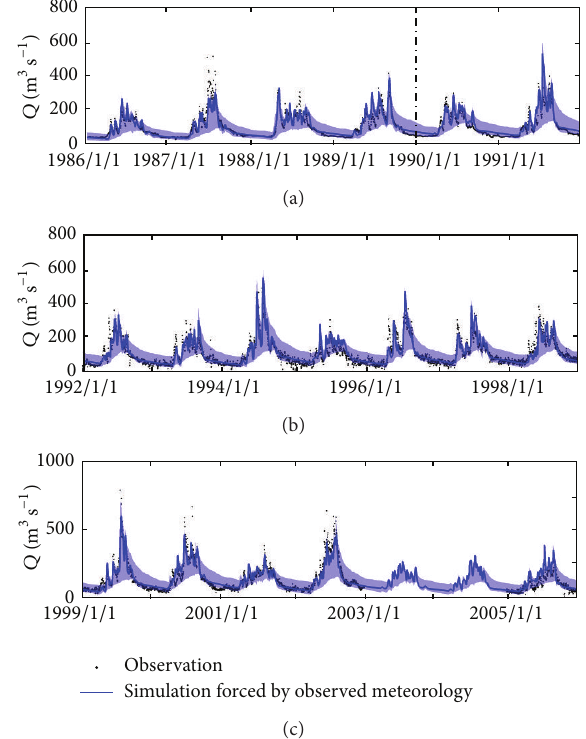
Figure 2: Time series of daily observed streamflows (dots) and simulated streamflows forced by observed meteorological data (blue line)forcalibrationperiod(1986–1989)andvalidationperiod(1990– 2005) with 95% prediction uncertainty bands (blue shaded